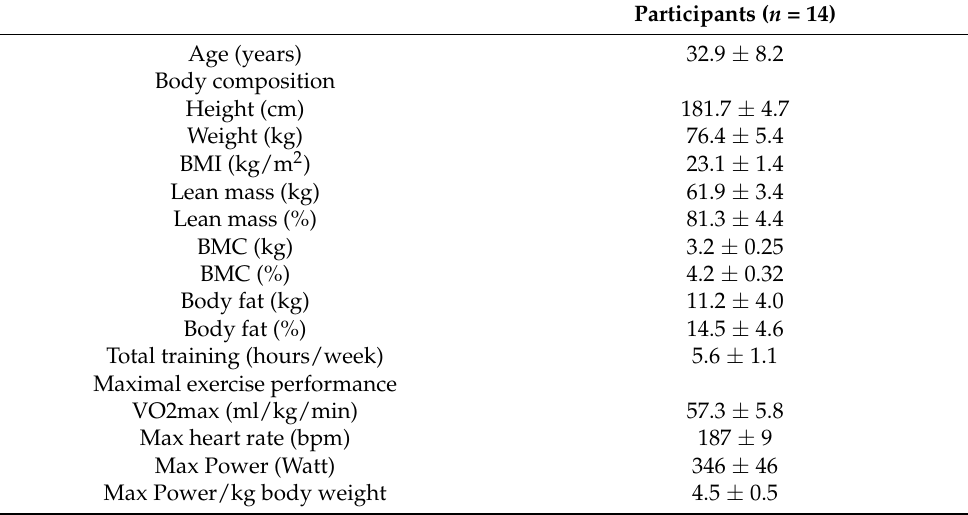
Means ± SD are shown. BMI: Body mass index; BMC: Bone mineral content. Physical characteristics are determined during a VO2max